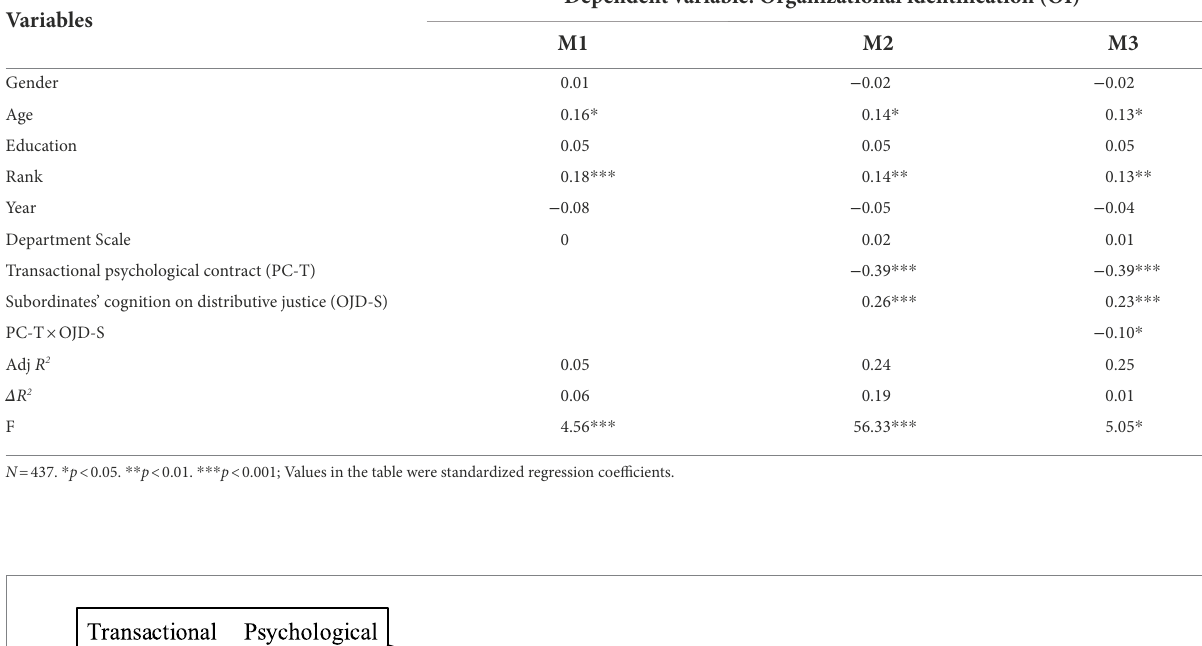
TABLE 5 Moderating effect of OJD-S to the relationship between PC-T and OI.